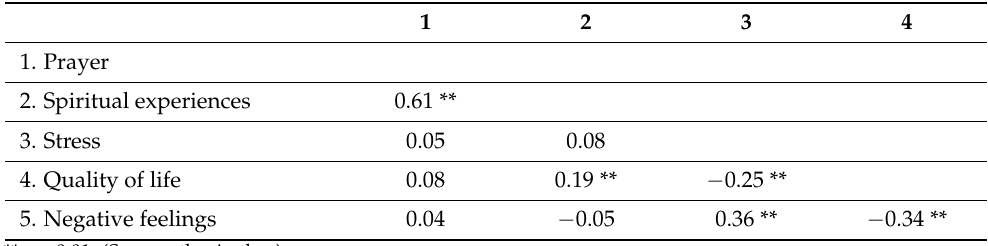
Table 2. Pearson’s correlation coefficients in a sample of Chilean students ( n = 177).